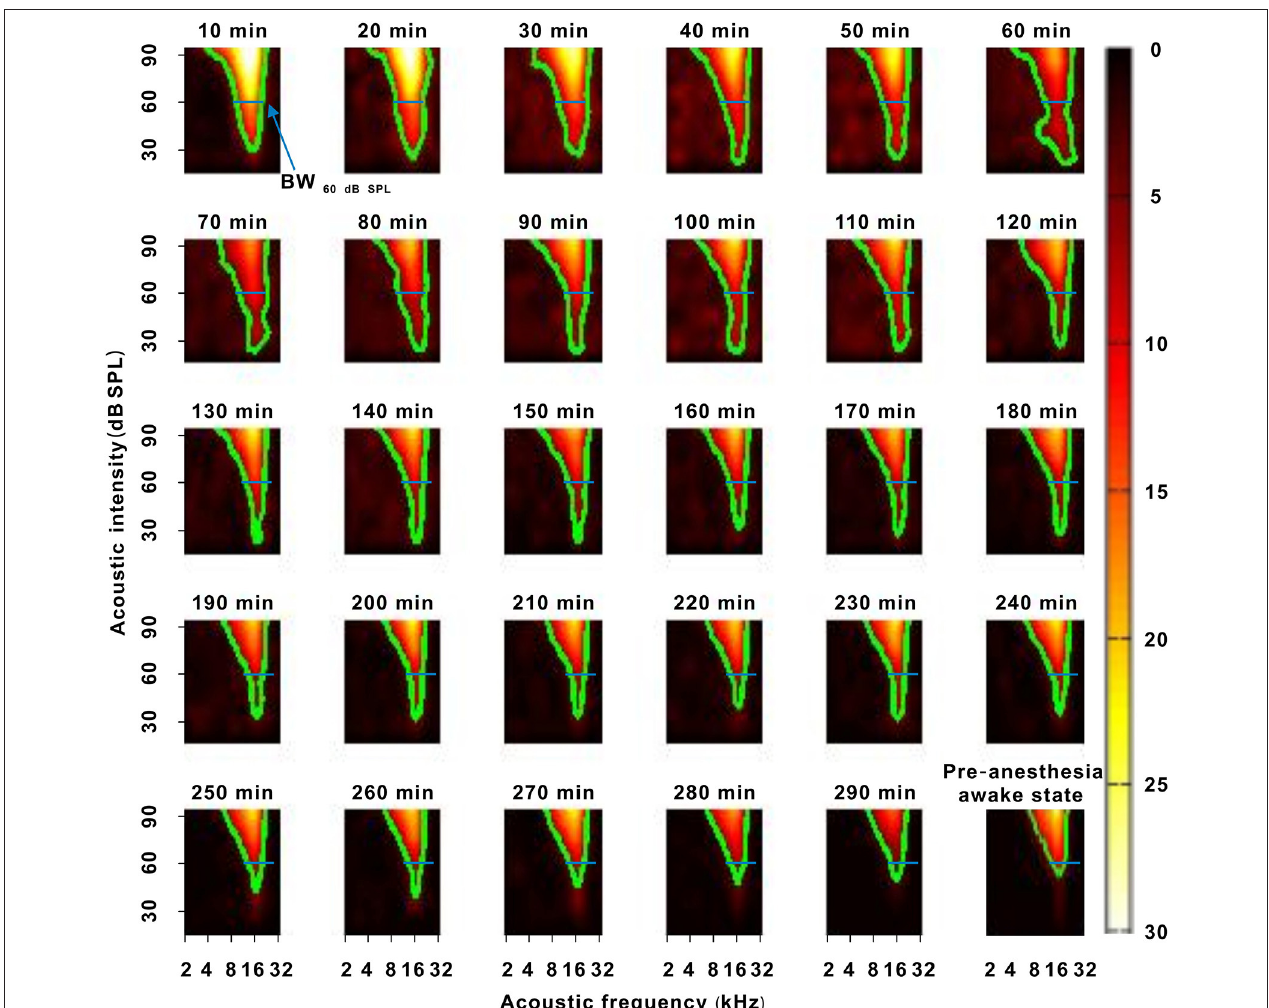
FIGURE 4 | A representative neuron with a change in frequency tuning. The 10–290min was the time after urethane anesthesia. Each green curve was the contour of the TRF. The width of the blue transverse line represented the BW 60 dB SPL in the first recording session. The last pseudocolor map in the bottom right corner was obtained under the pre-anesthesia awake